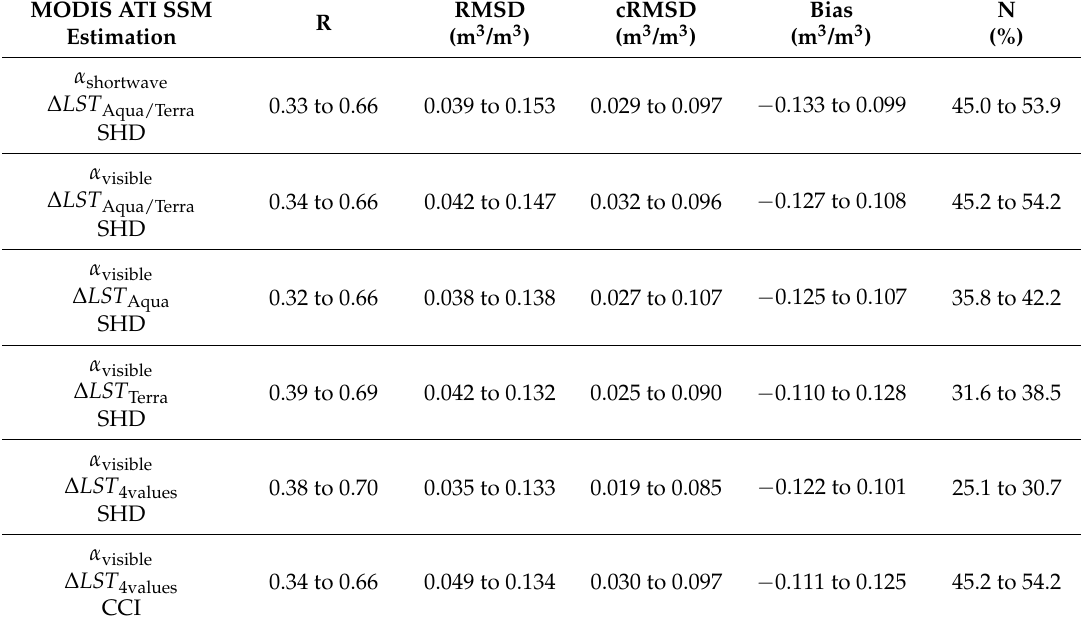
Table 1. Statistics obtained from the comparison of the different MODIS ATI SSM estimations with the in situ SSM over all the REMEDHUS stations. N indicates the number of coincident data